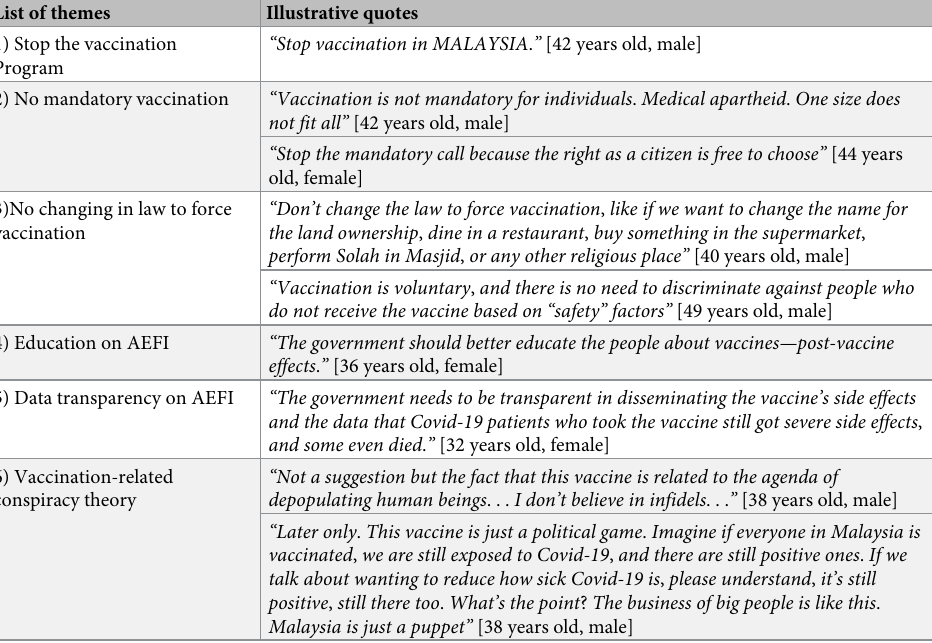
Table 4. Analysis of themes for the suggestion on the COVID-19 vaccine programme